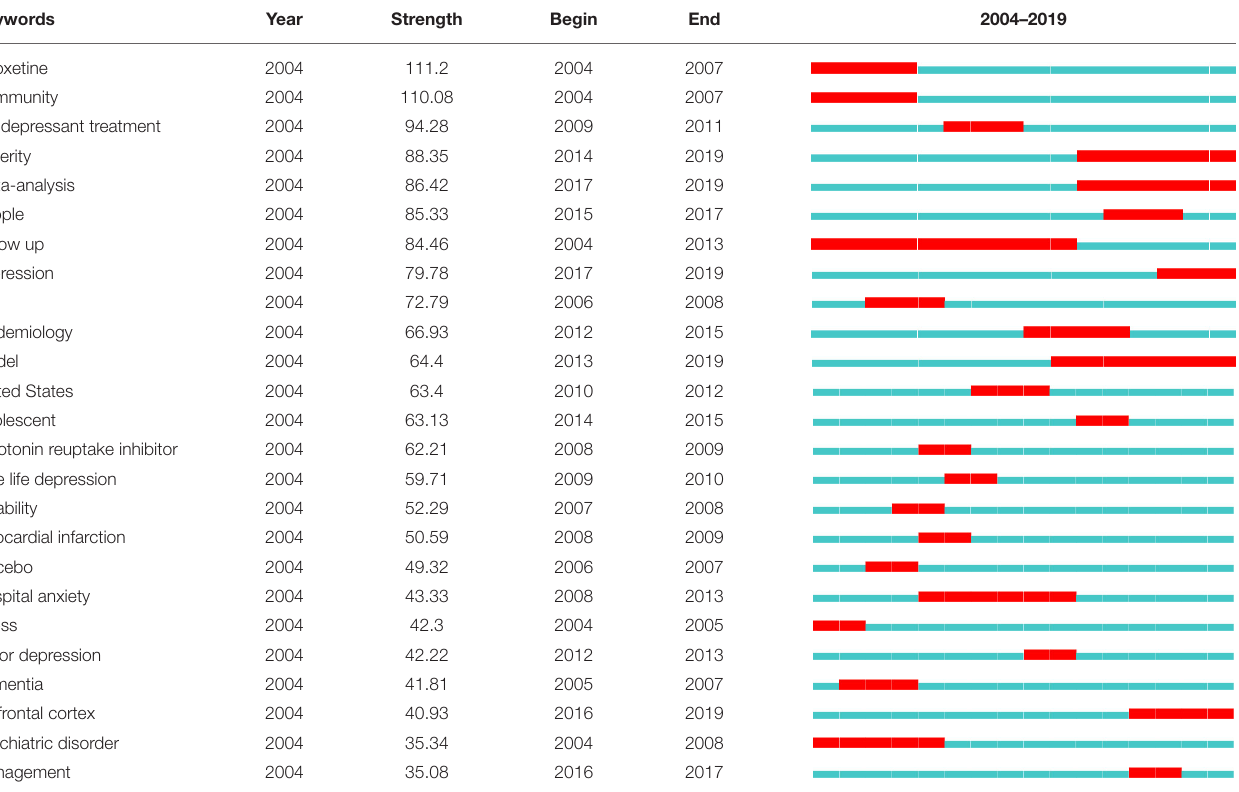
TABLE 9 | Top 25 keywords with strongest citation bursts in the period of